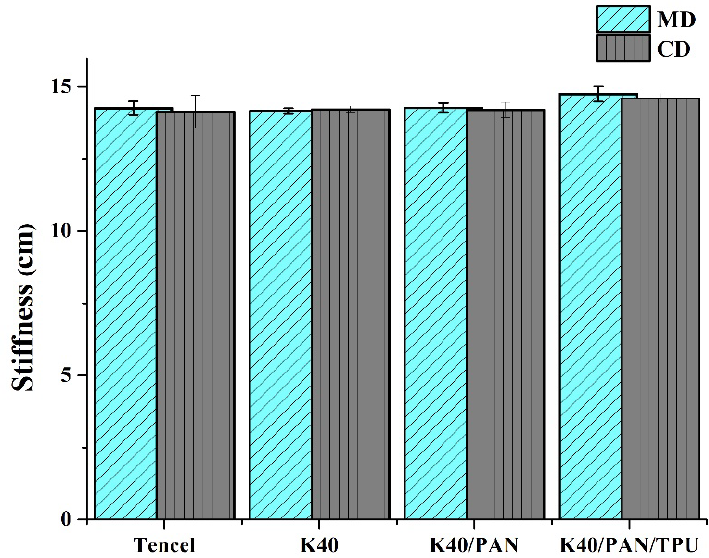
Figure 5. Stiffness along the MD and CD of Tencel, K40, and K40/PAN/TPU lay-up compound matrices.